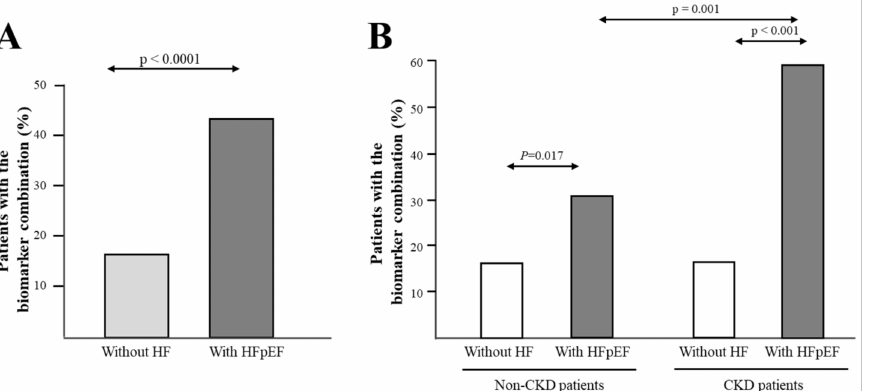
Figure 1. Frequency distribution of the combination of biomarkers of malignant myocardial fibrosis as defined in the text. ( A ) Panel A shows frequency distribution in all hypertensive patients classified according to the absence of heart failure (HF) or the presence of HF with preserved ejection fraction (HFpEF); ( B ) Panel B shows frequency distribution in patients without and with chronic kidney disease (non-CKD and CKD groups, respectively) classified in subgroups according to the absence of HF or the presence of